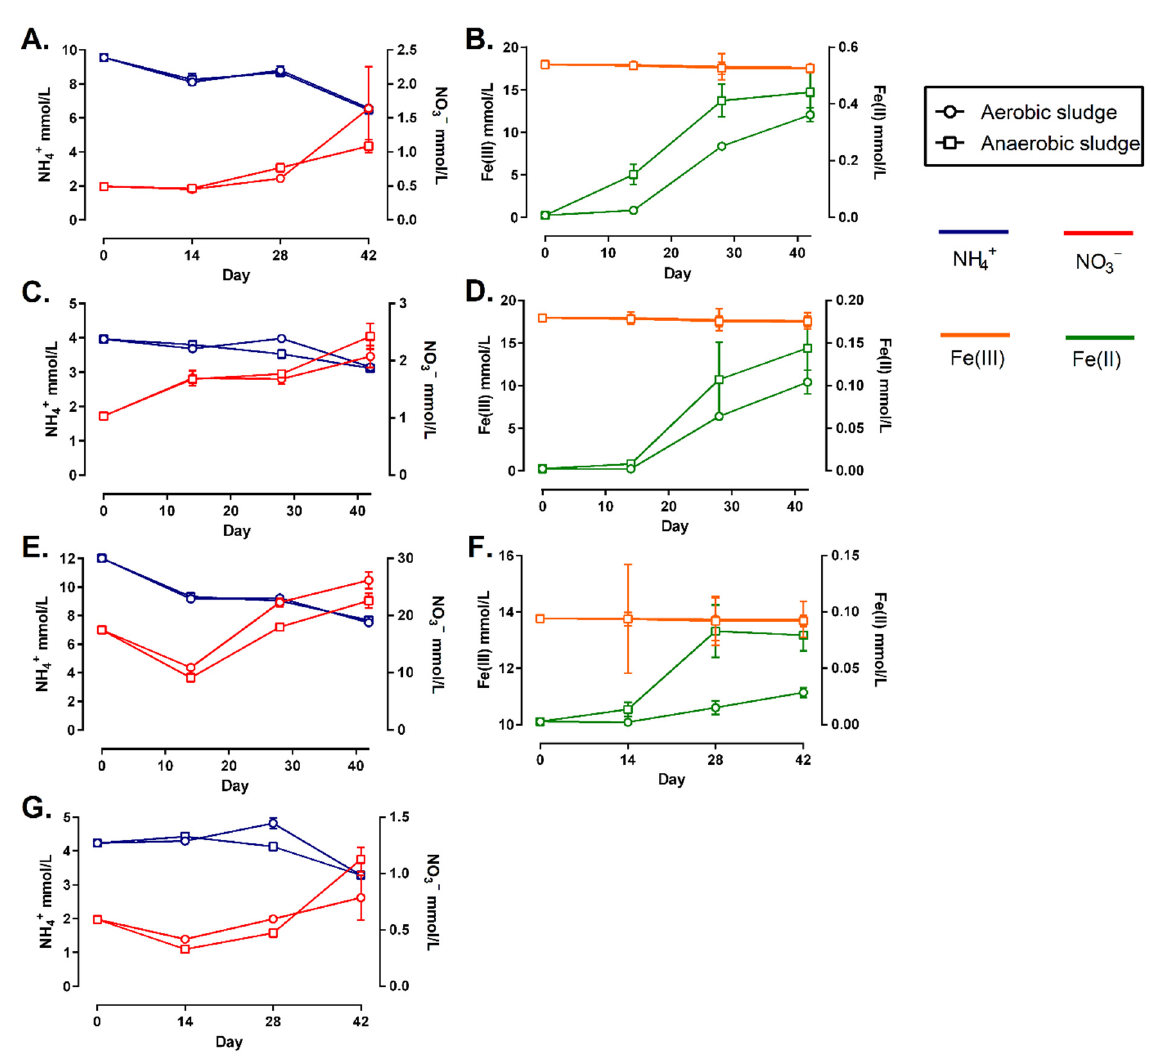
Figure 5. Concentration of NH 4+ , NO 3 − , Fe(II), and Fe(III) over 42 days of incubation, and measurements using different iron sources: ( A , B ) FeCl 3 ; ( C , D ) ferrihydrite; ( E , F ) gothite; and ( G ) without Fe (control). The concentrations of the different parameters were grouped on the right and left y-axes, in order to be easily visualized.